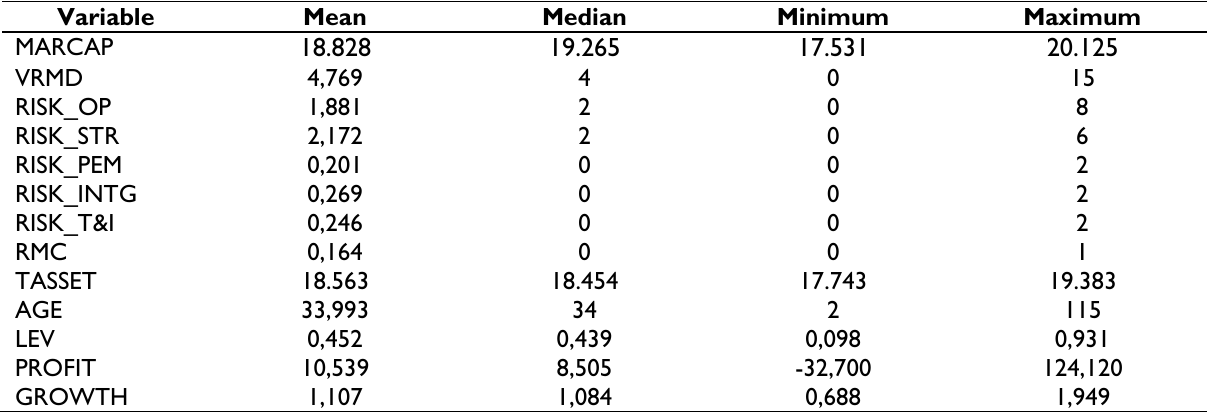
Table 2. Description of